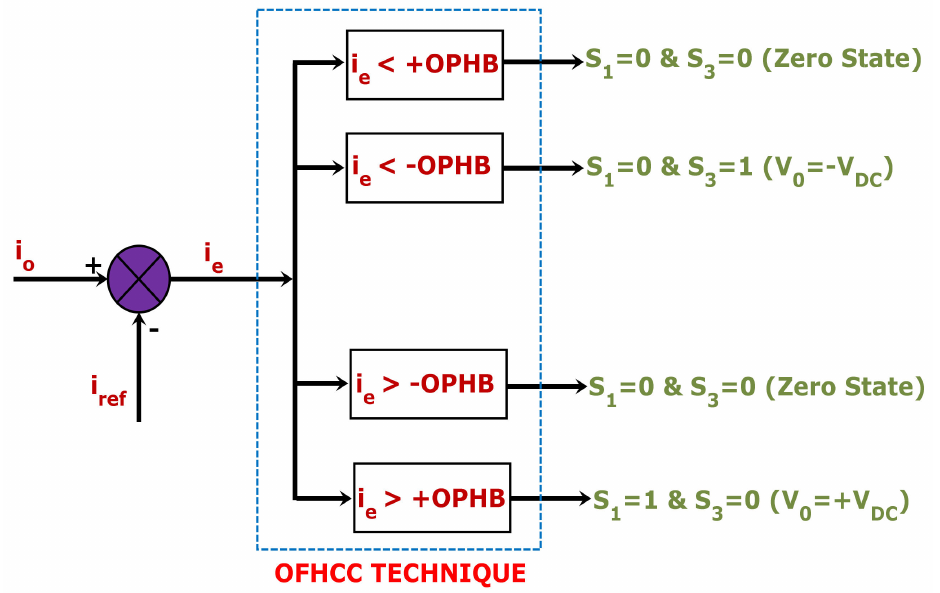
Figure 8. Switching strategy of offset hysteresis band current controller